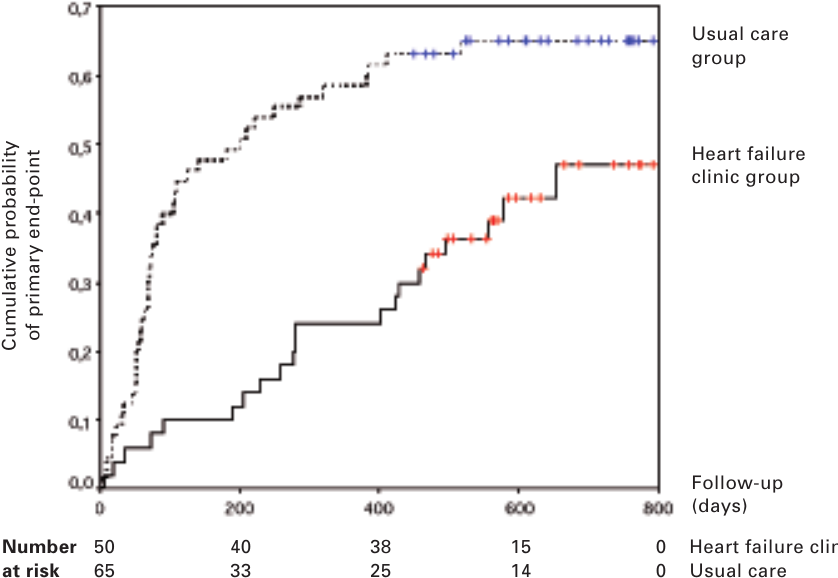
Figure 1 Cumulative proba- bility of heart failure rehospitalisation or death according to the type of